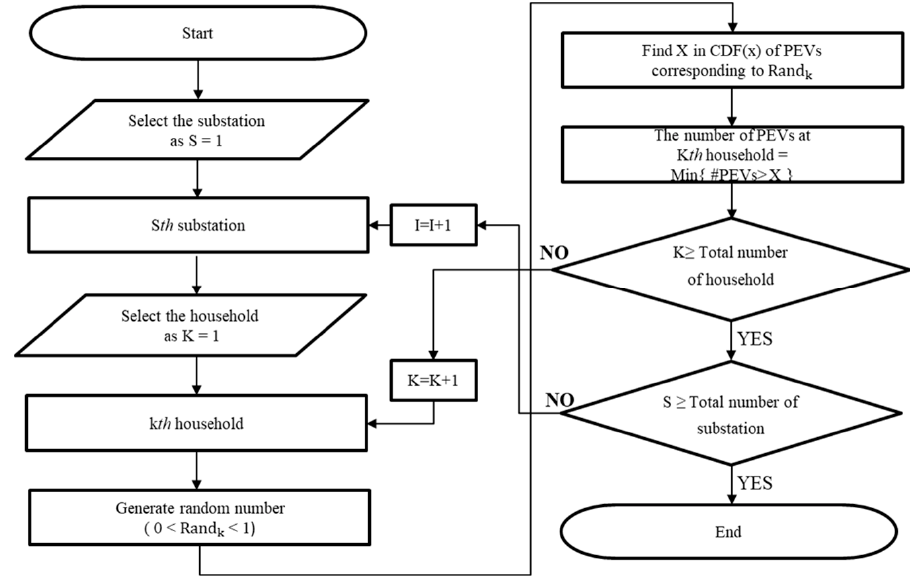
Figure 3. Stochastic modeling procedure for distribution of PEVs over 154 kV substations.